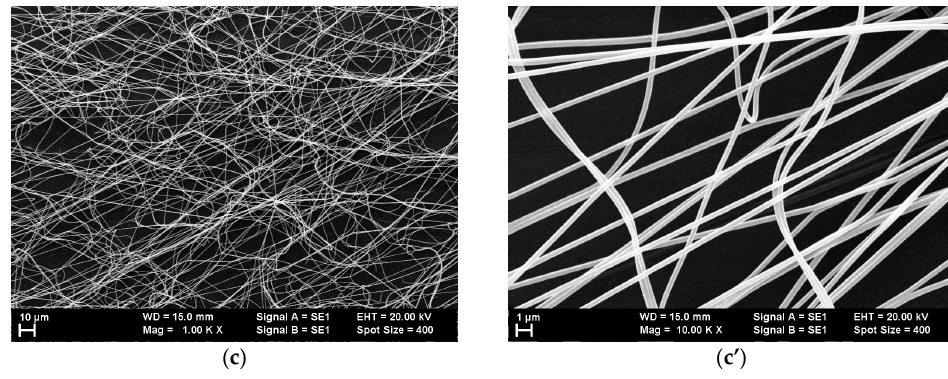
Figure 10. Scanning electron microscopy (SEM) images of submicronic fibers obtained by electrospinning of mixtures of single-dye-doped polymer fibers: ( a , a’ ) mix 1; ( b , b’ ) mix 2; ( c , c’ ) mix 3.